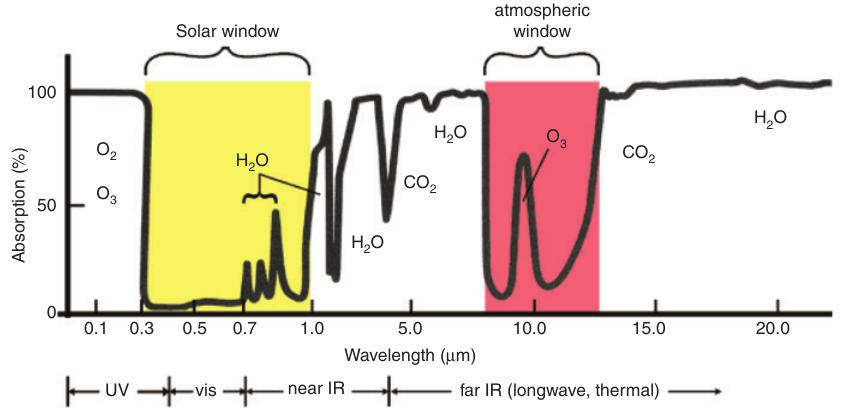
Figure 18: The absorption profile of Earth’s atmosphere from UV to IR. The graph shows the regions of the electromagnetic spectrum (light) that are absorbed by specific molecules. (Adapted from a figure in